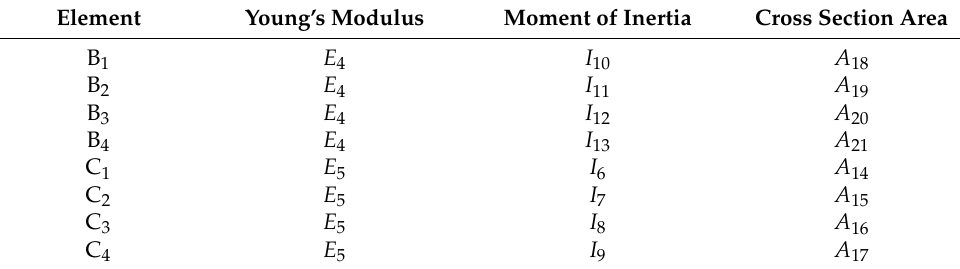
Table 12. Statistical properties of random variables.